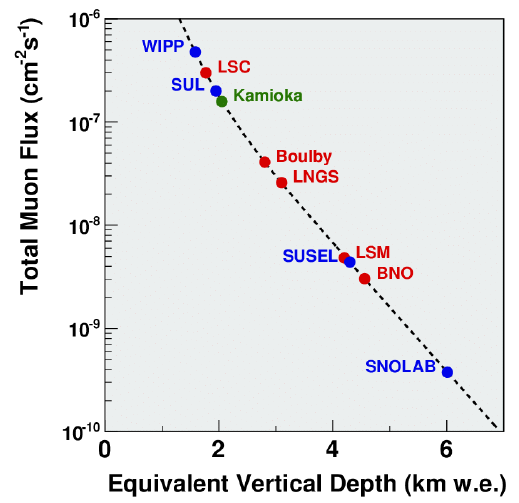
Figure 16: The intensity of muons vs. depth, with labels indicating the depth loca- tions of various underground laboratory facilities. Taken from [ 24